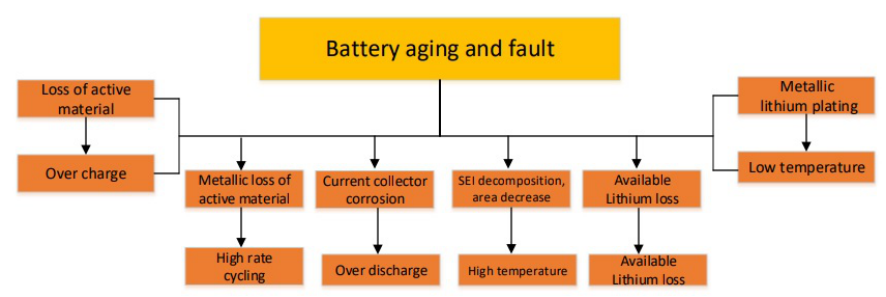
Figure 1. Battery aging